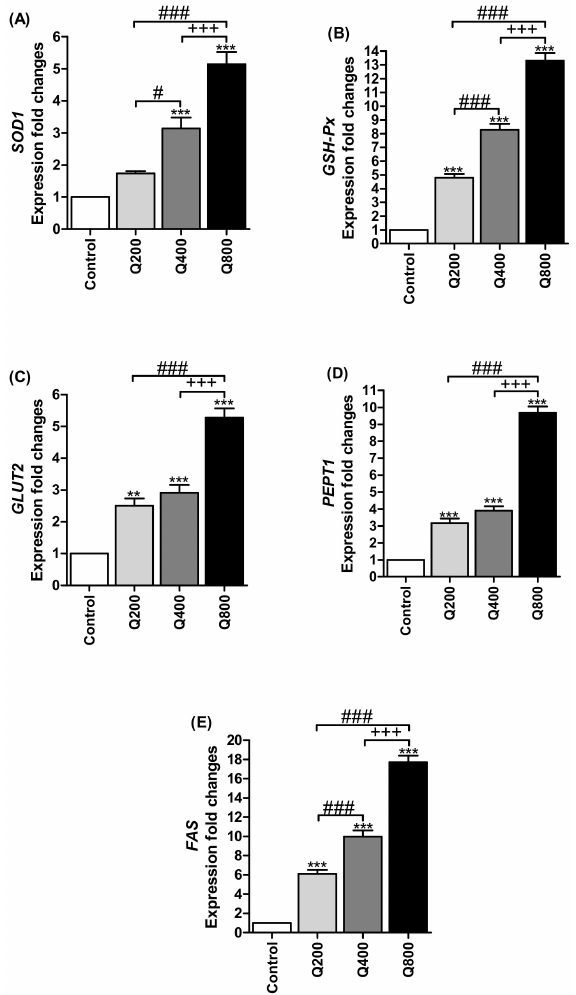
Figure 3. RT-PCR validation of the SOD1 ( A ) , GSH-Px ( B ), GLUT2 ( C ) , PEPT1 ( D ), and FAS ( E ) genes. ** p < 0.01 and *** p < 0.001 vs. control. # p < 0.05 and ### p < 0.001 vs. Q200. +++ p < 0.001 vs. Q400. Statistical analysis was performed using one-way ANOVA and Tukey’s post hoc test for multiple comparisons. Q200, birds fed 200 ppm. Q400, birds fed 400 ppm. Q800, birds fed 800